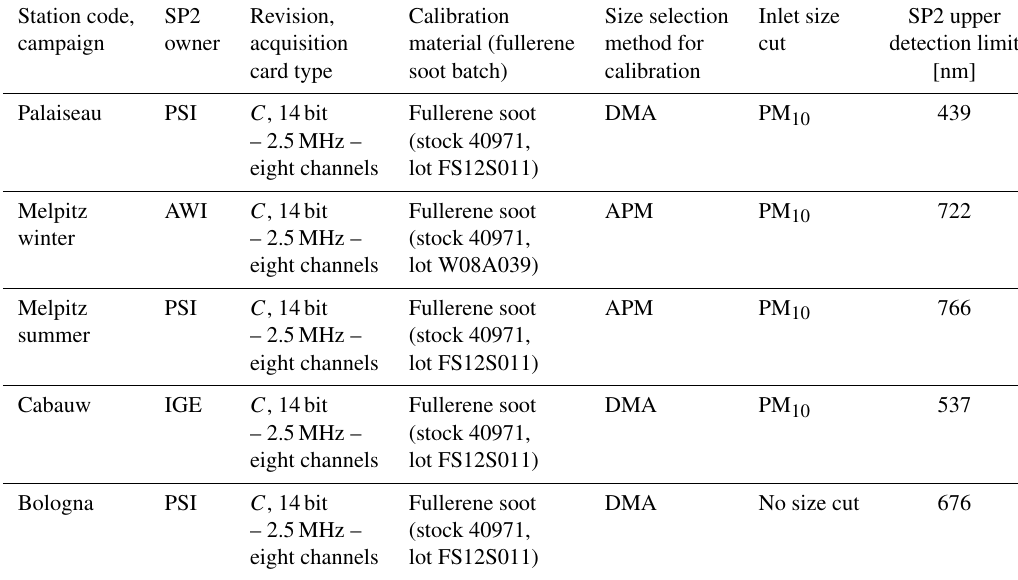
Table 3. Description of the measurement methodology for rBC mass concentration adopted during each campaign, along with SP2 owner (Paul Scherrer Institute (PSI), Alfred Wegner Institute (AWI) and Institut de Géosciences de l’Environment (IGE)), calibration material (fullerene soot batch), calibration method selection and inlet size